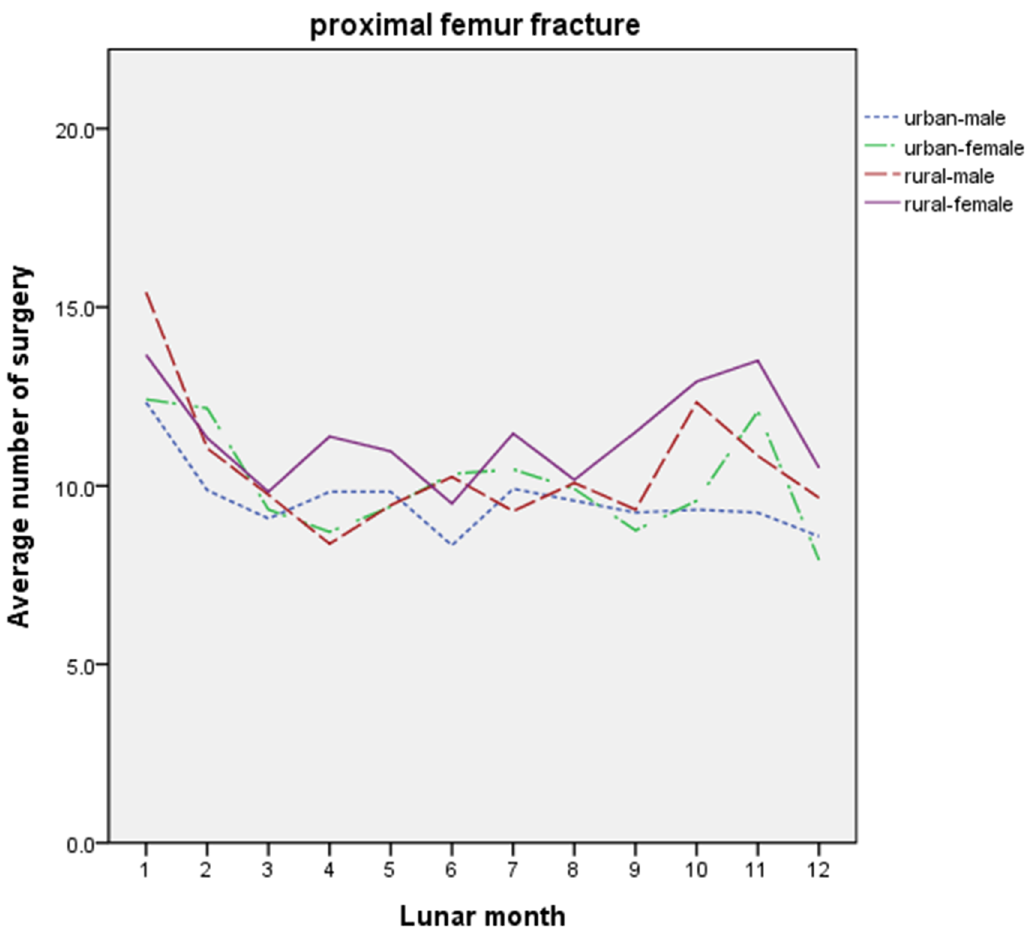
Fig 2. Average numbers of PFF surgeries categorized by location of residence and gender of patients in each lunar month from 2000 to 2011. X-axis: the 12 lunar months; Y-axis: the average number of the PFF surgeries. PFF: proximal femur fracture.